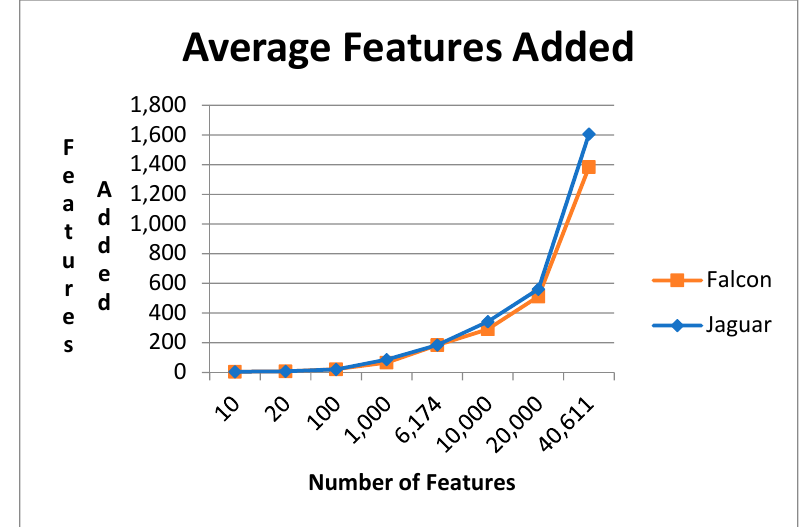
Figure 9. Average features added.